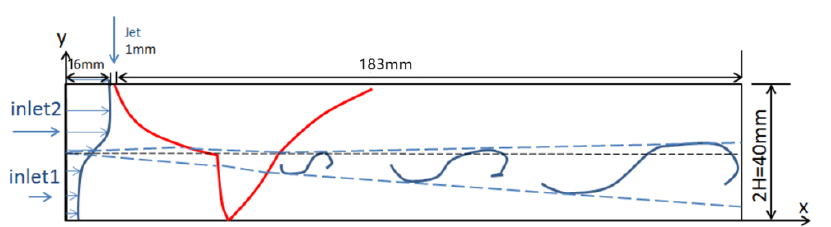
Figure 1. Schematic of calculation model and flow field structure. (The red solid line represents the position of the jet shock wave in the flow field, the area between the blue dotted lines is the mixing layer, and the blue arrow represents the incoming flow and the wall jet respectively).